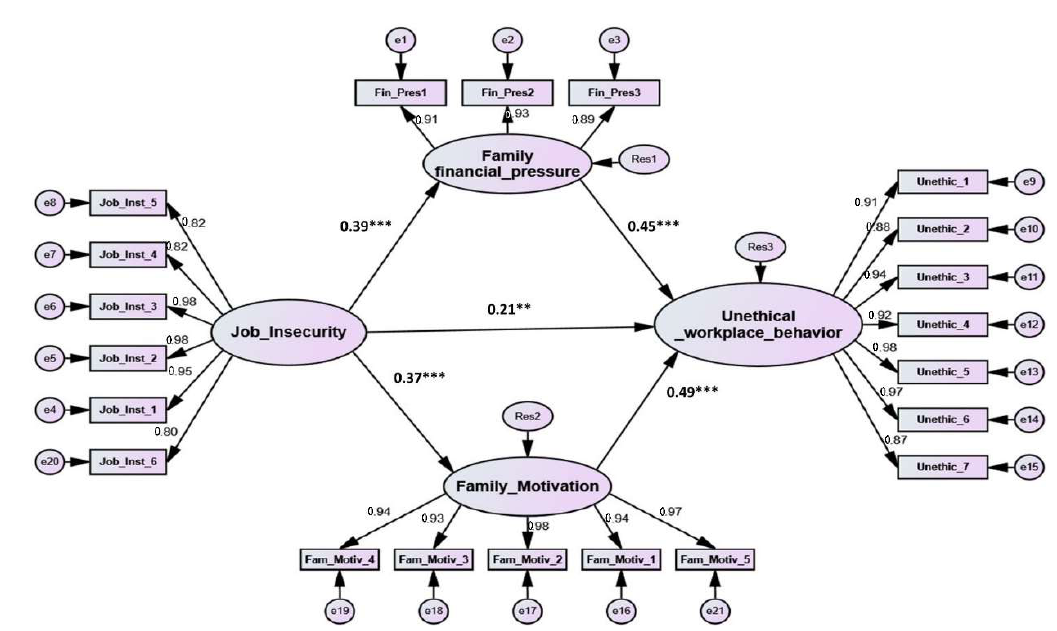
Figure 2. The structural model. ***: significant level below 0.001, **: significant level below